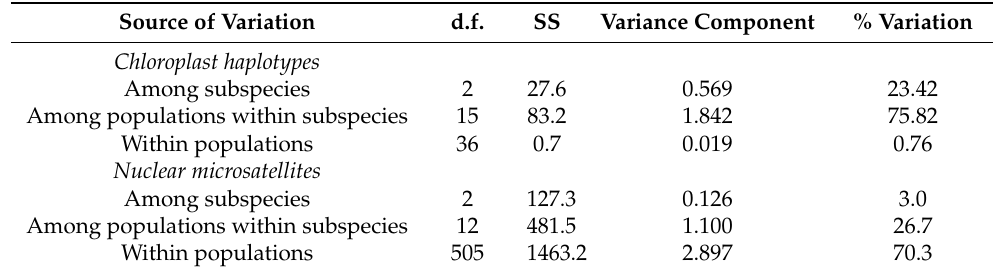
Table 3. Analysis of molecular variance (AMOVA) of Banksia nivea subspecies based on chloroplast haplotypes and nuclear microsatellite